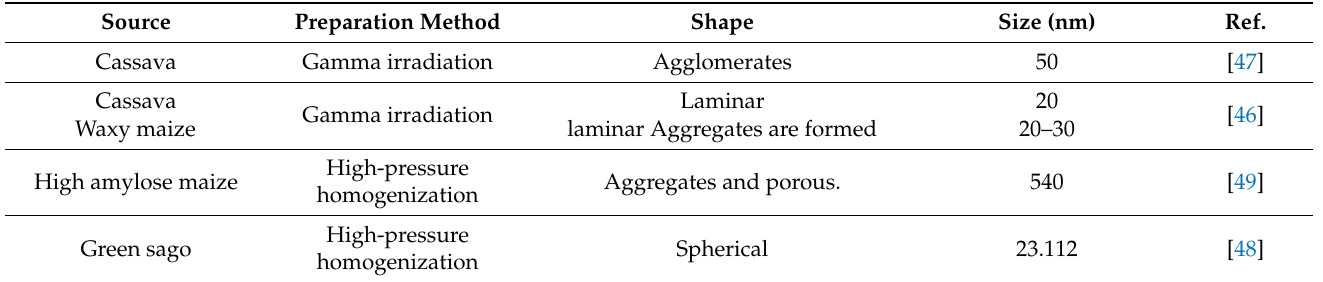
Table 2. Morphological characteristics and size of